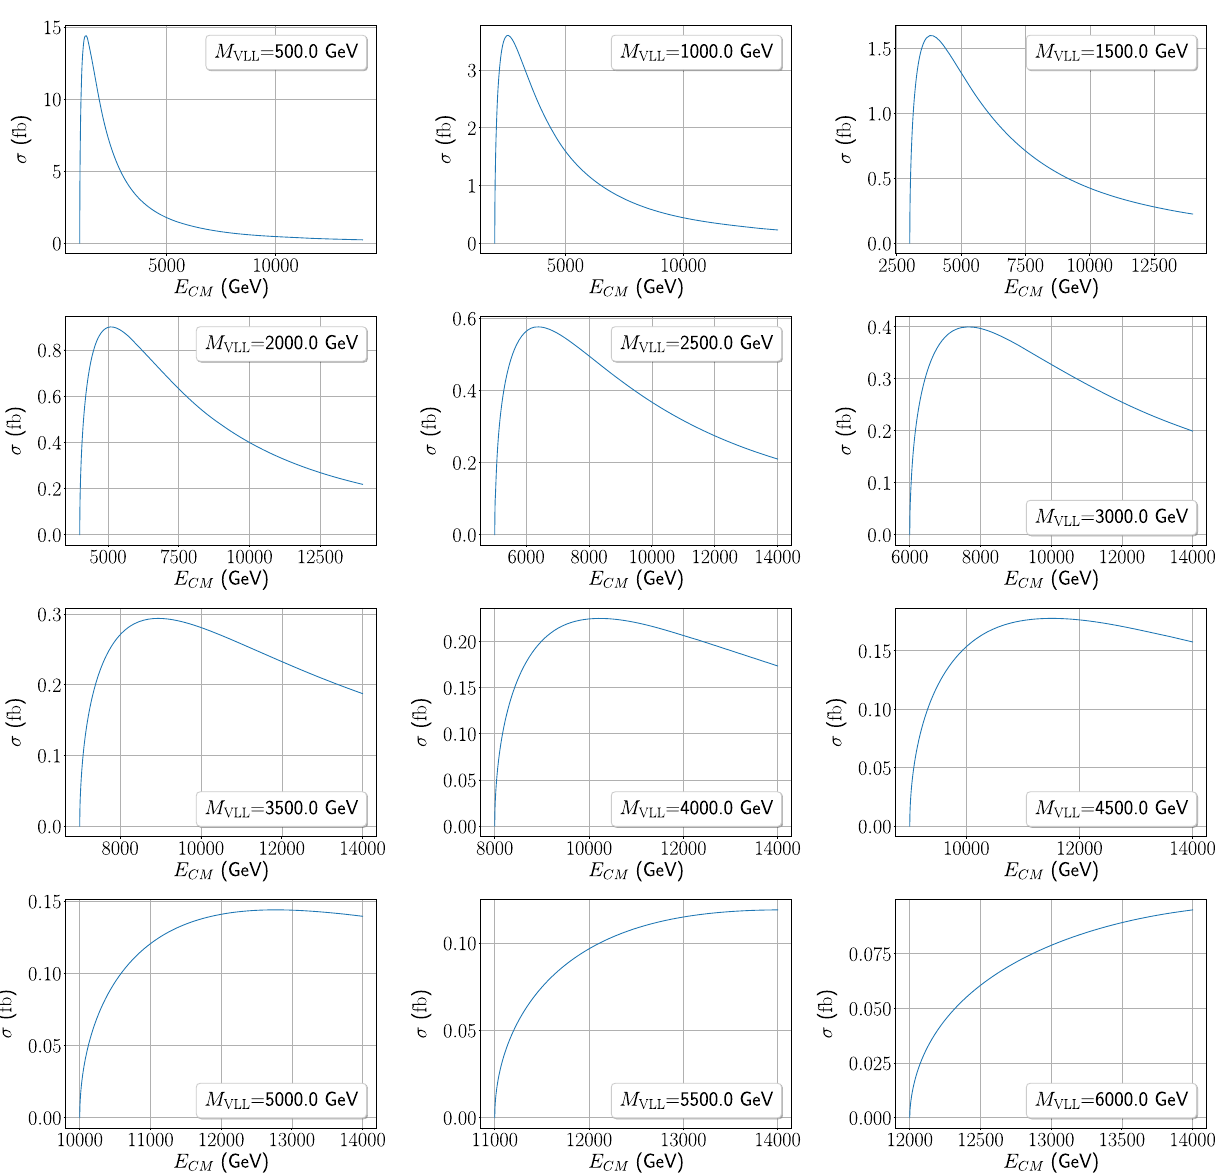
Fig. 9 VLL pair production cross section, in fb, as a function of centre-of-mass energy for a lepton collider, in GeV. Each individual box is representative of a different mass of the singlet VLL, which is also given in